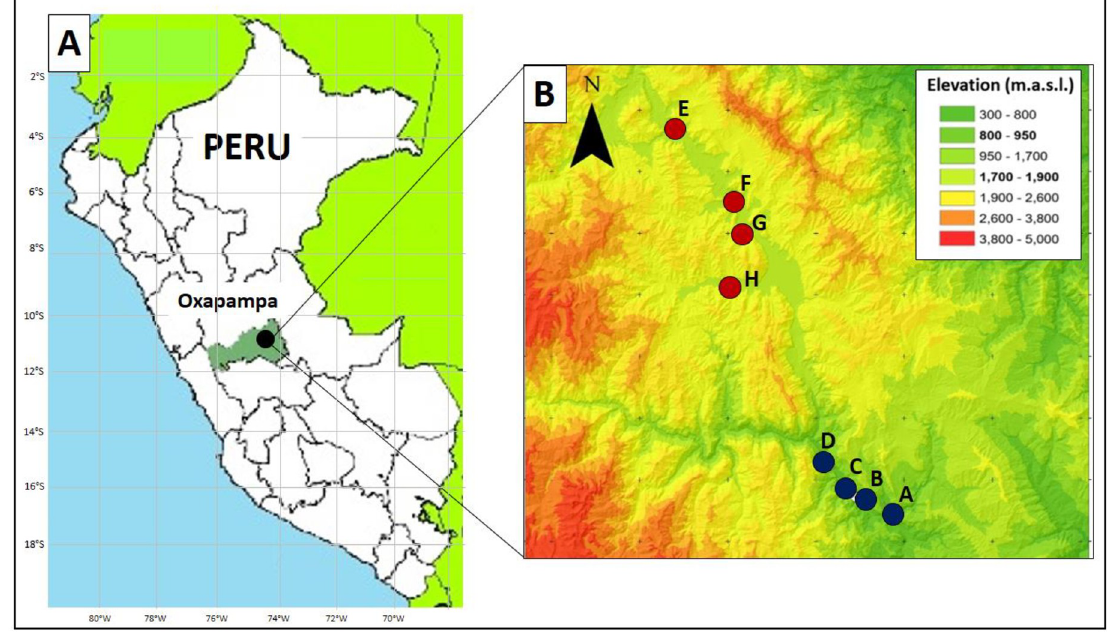
Fig 1. Location of sampling sites. A: Map of the study site (Oxapampa, eastern Pasco, Peru). B: Close-up of the eight farm locations: four farms (A–D) were at the low elevation (800–950 m above sea level) and four farms (E–H) were at the high elevation (1,700–1,900 m above sea level). See S1 Table for details on geographical coordinates and elevation for each farm. m.a.s.l. = meters above sea level. (source: QGIS 3.10.14, https://www.qgis.org, Accessed 29 Jan